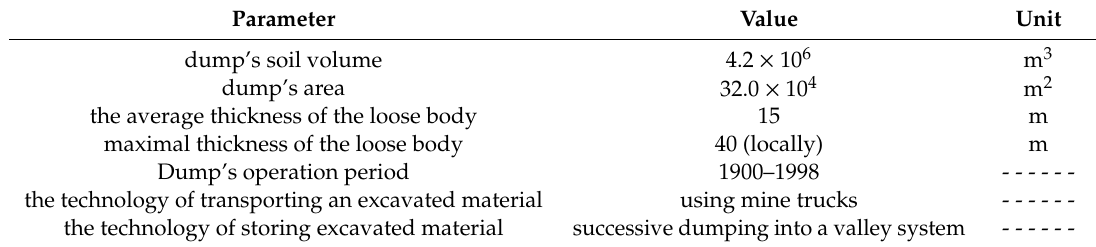
Table 1. The Hedwig mining dump–basic technical parameters (see also